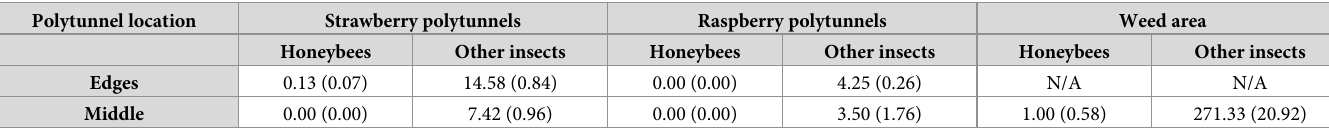
Table 2. Average insect count per pan-trap location along the polytunnels with the mean and standard error of the mean (SEM) shown in brackets. Polytunnel